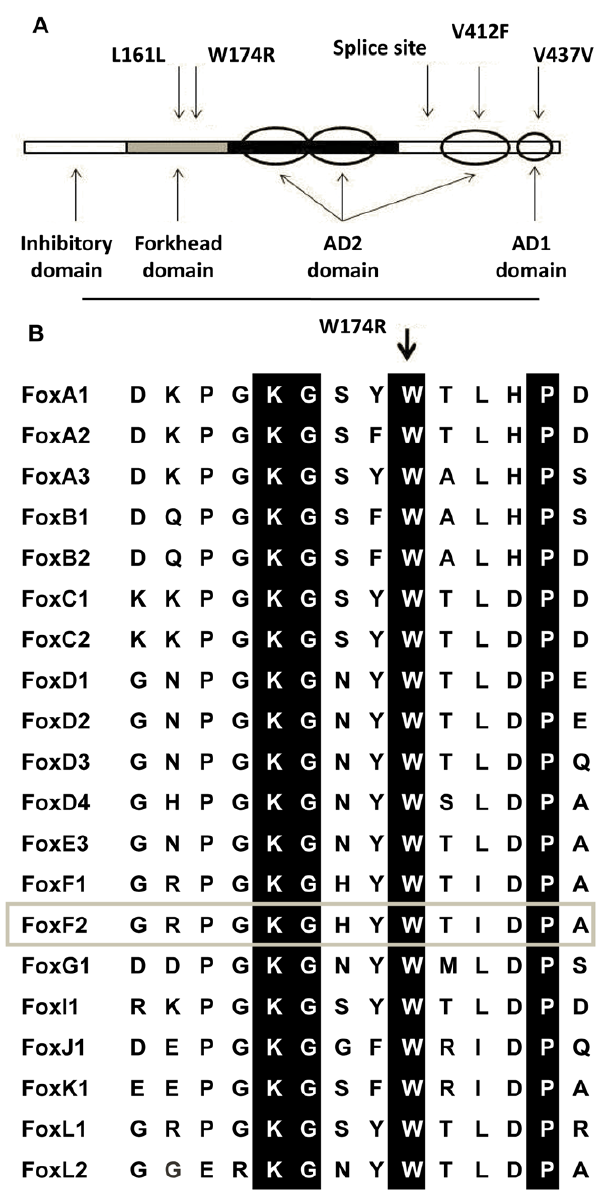
Figure 1. Foxf2 structural organization. A , Protein domains of Foxf2 with mouse mutations identified in the DHPLC screen. The domain structure is shown as described for mouse [23] including two activation domains at the 5 9 end, but overlayed by the activation domain structure that was described for the human gene [49] with AD2 synergistic sub-domains (ovals) and AD1 domain (circle). B , The tryptophan codon at position 174 is conserved in the forkhead domain of all Fox proteins, of which several examples are shown. Foxf2 is highlighted by the grey box. Conserved residues are highlighted in